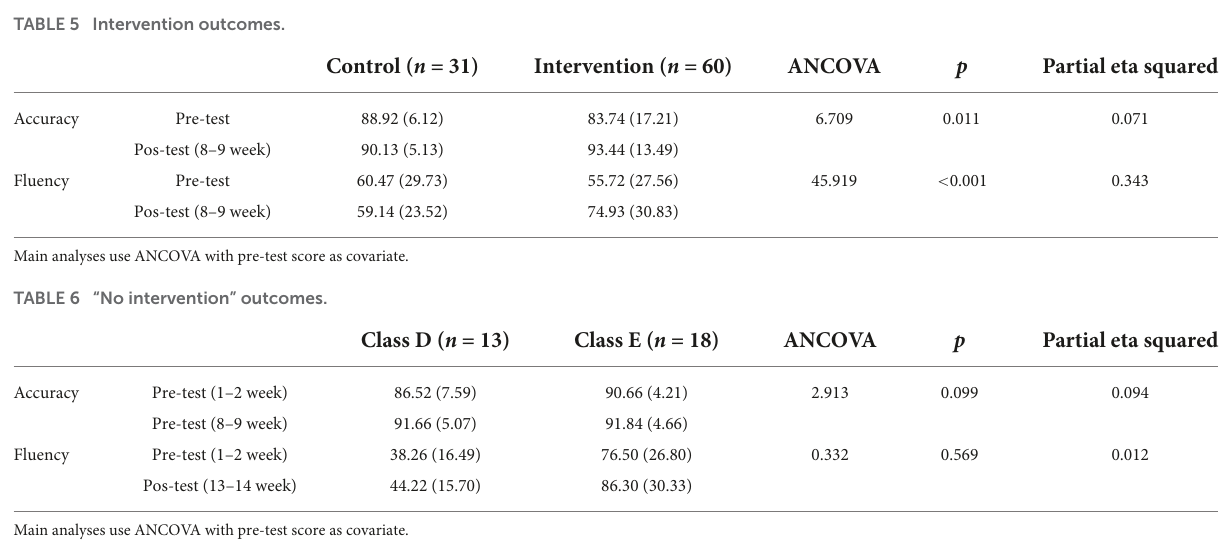
TABLE 7 Accuracy and fluency scores per evaluation